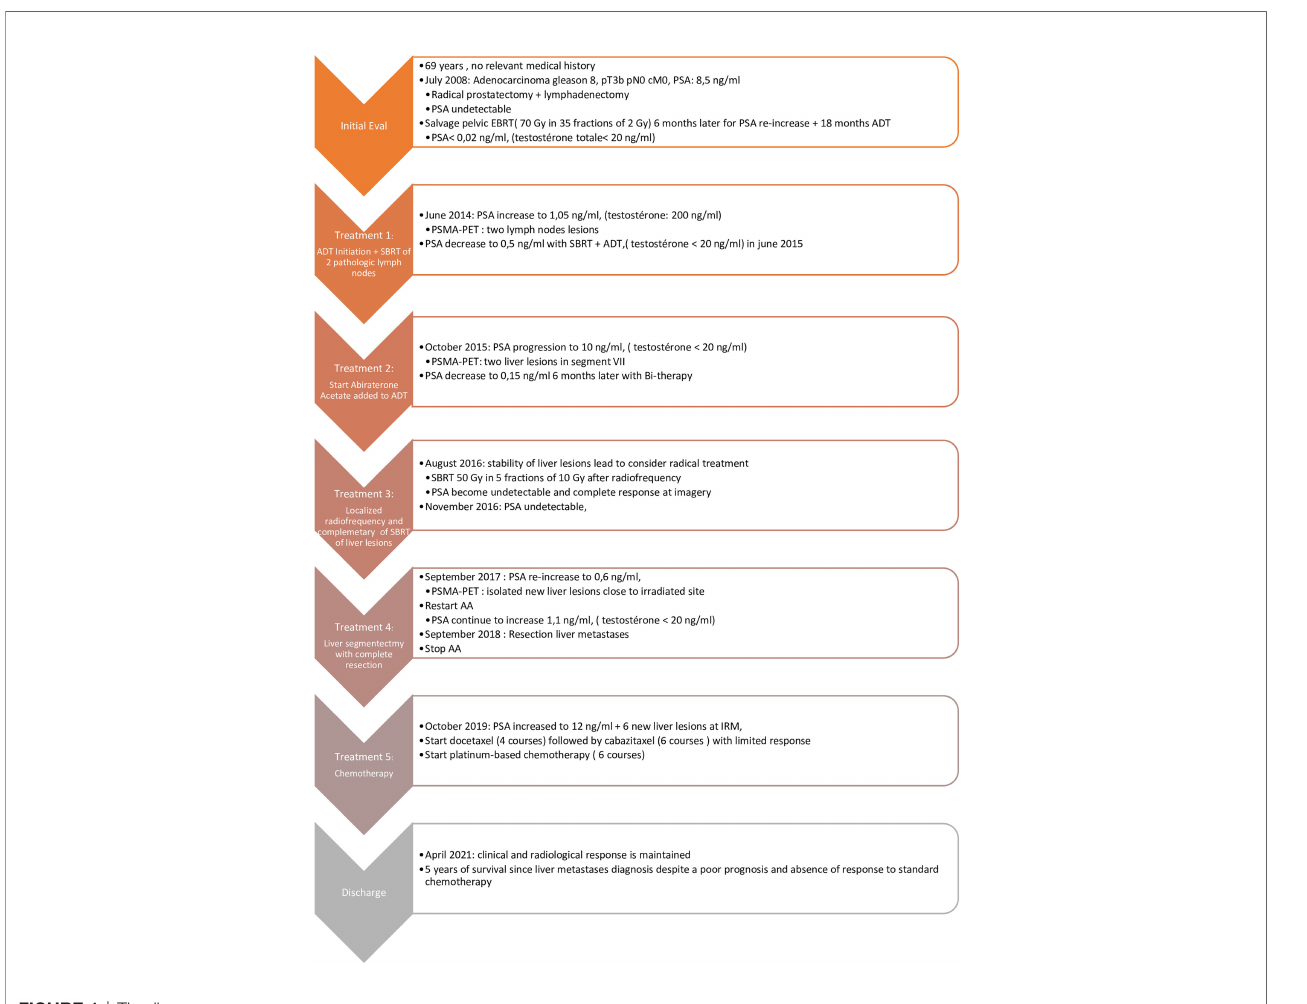
FIGURE 1 | Timeline.